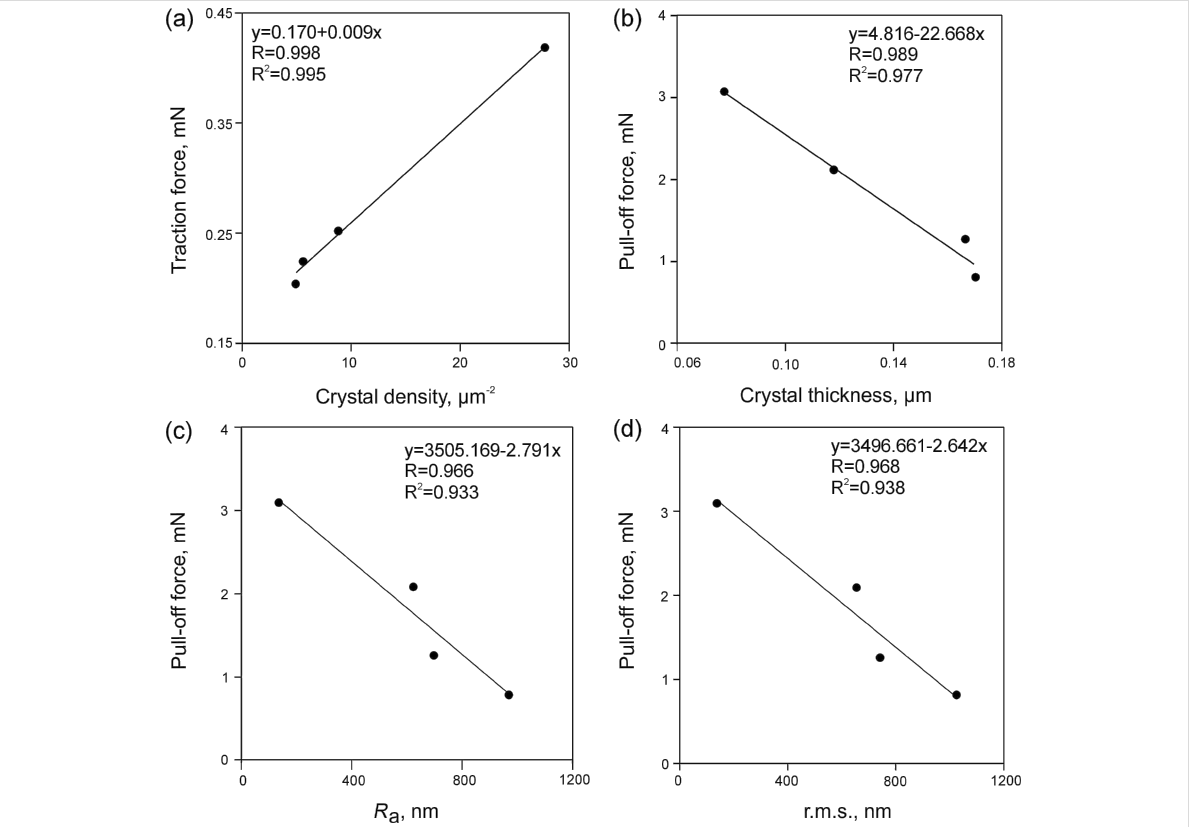
Figure 4: Traction forces of male beetles Coccinella septempunctata vs crystal densities (a) and pull-off forces of PDMS semi-spheres vs crystals thickness (b), mean roughness R a (c), and root mean square of roughness r.m.s. (d). Lines indicate linear regressions.